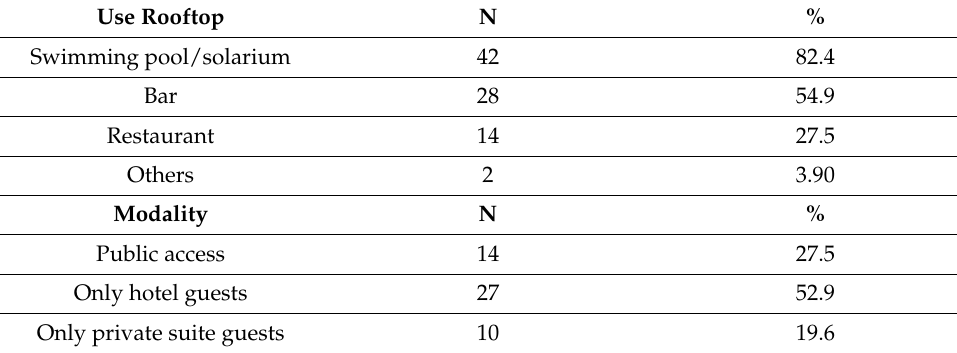
Table 1. Characteristics of the supply created by